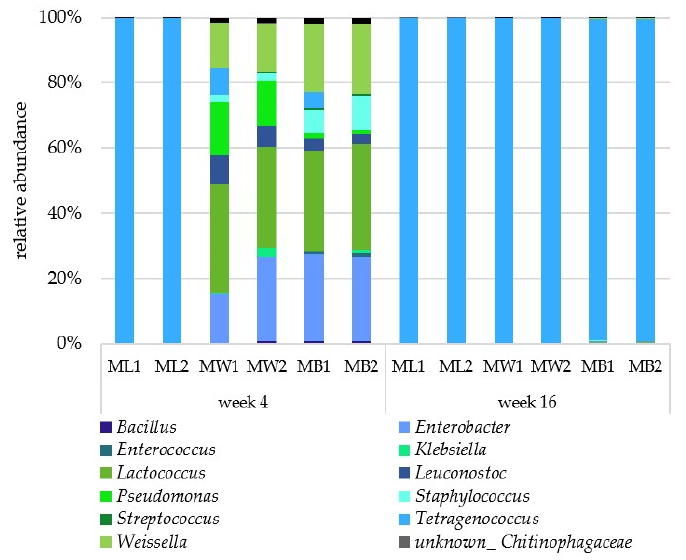
Figure 3. Diversity of bacteria during moromi fermentation determined via 16S rDNA amplicon sequence analysis. Data were evaluated using IMNGS and RHEA [14,15].